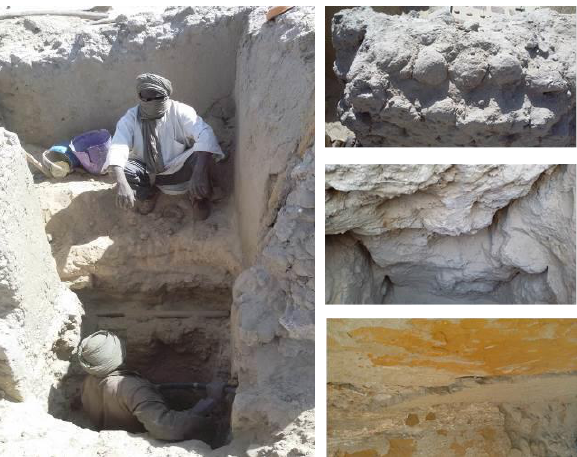
Figure 3. One of the archaeological digs and samples of strata observed © Yamoussa F.